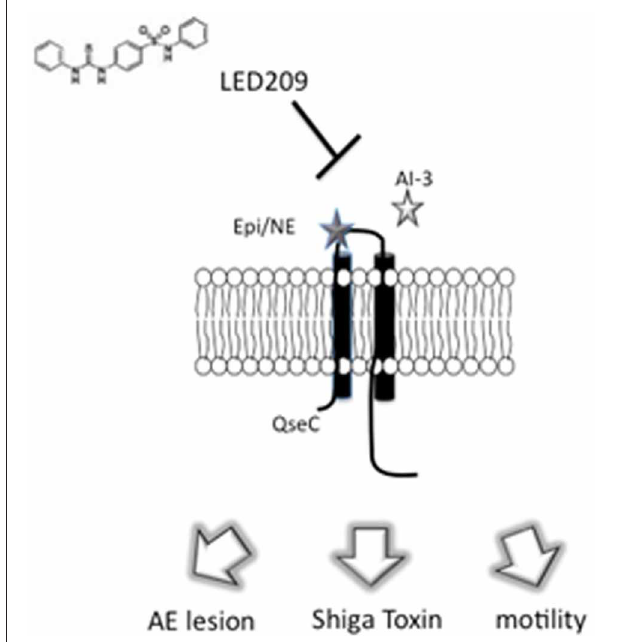
FIGURE 3 | Inhibition of signal transduction by LED209. LED209 prevents autophosphorylation of the adrenergic sensor QseC, which is required to activate the expression of genes involved in colonization of the intestinal